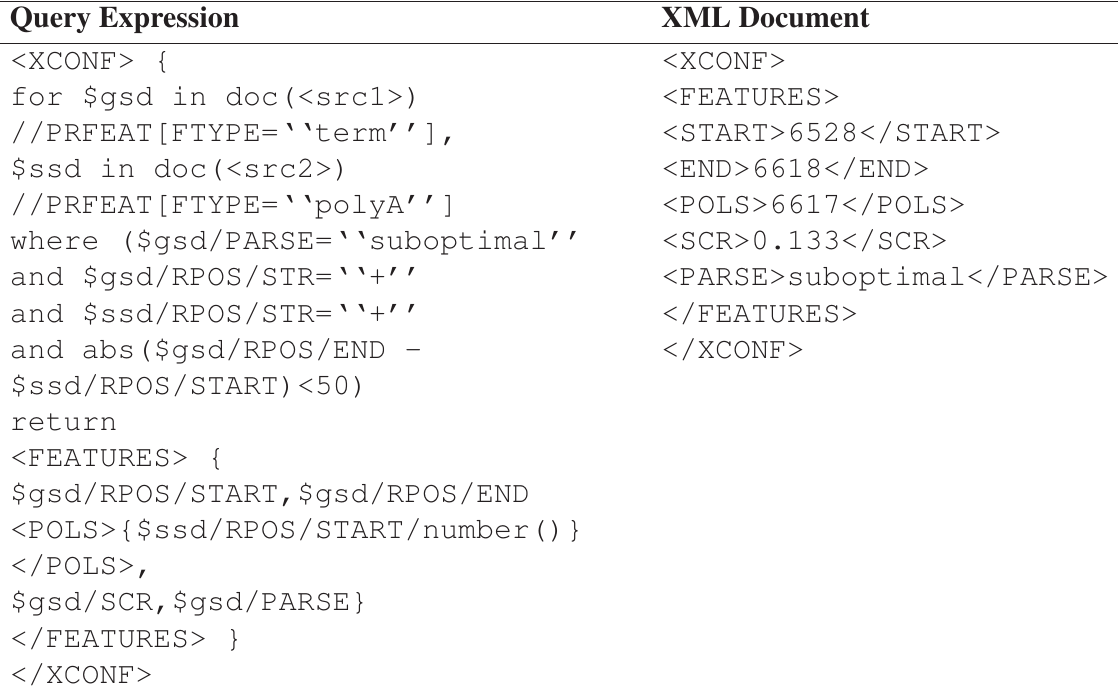
Table 2: An example FLWR expression (in the left column) resulting in new tagged elements as defined in the return clause. The right column contains a fragment of the matching data that were extracted from the corresponding p53 XML-formatted gene